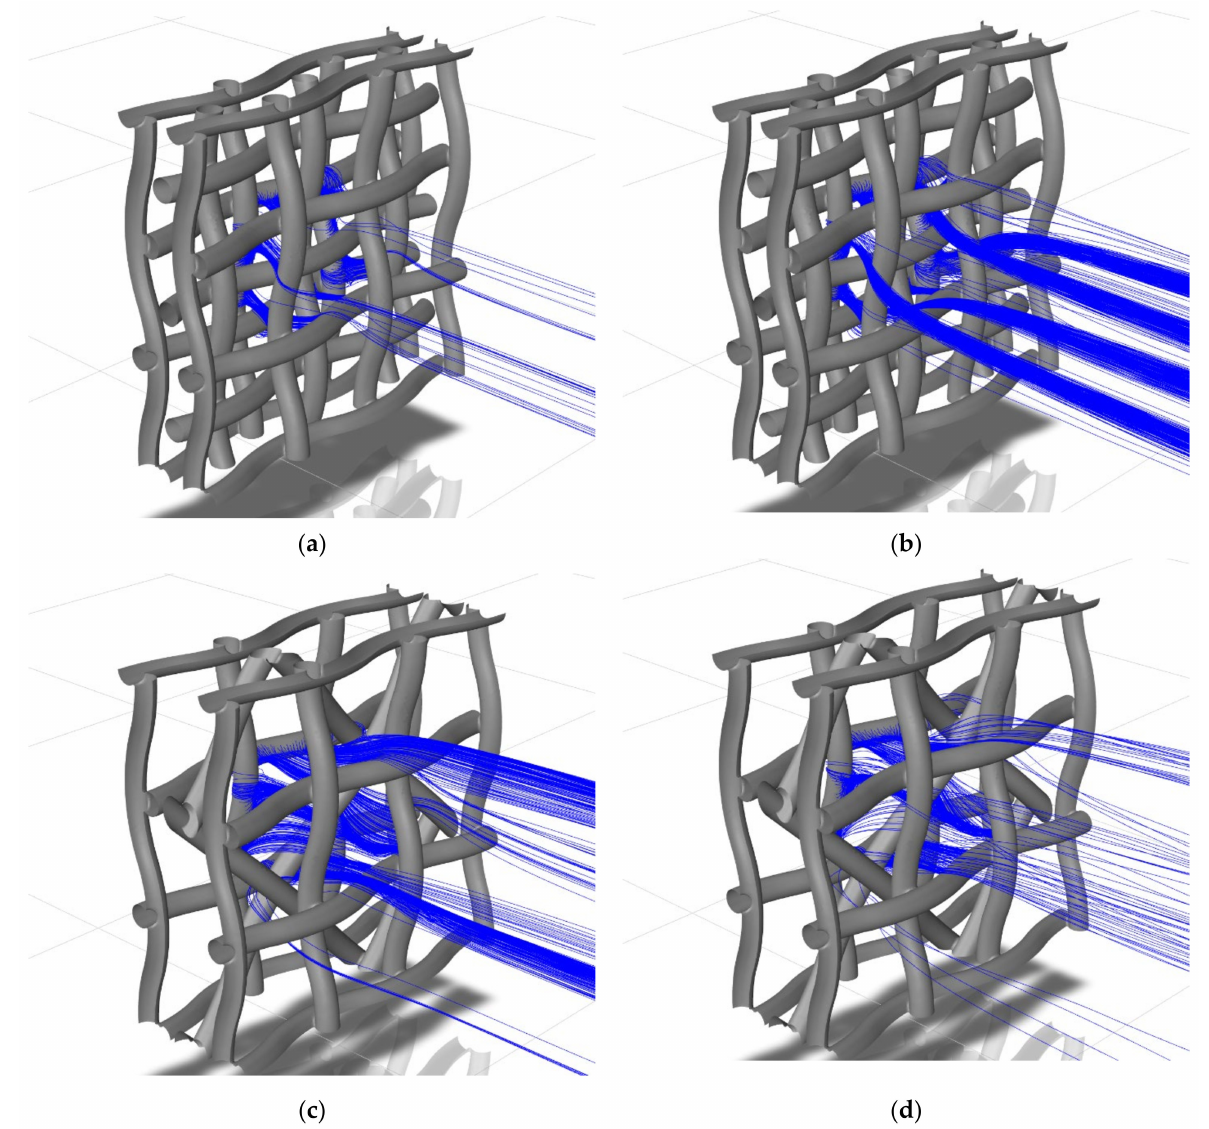
Figure 12. Trajectories of platinum particles for: ( a ) Geometry A, contact time of 0.001 s; ( b ) Geometry A, contact time of 0.00025 s; ( c ) Geometry B, contact time of 0.001 s; ( d ) Geometry B, contact time of 0.00025